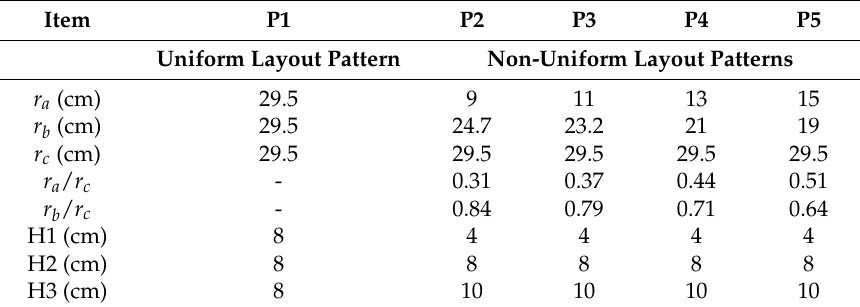
Figure 2. Block plan for non-uniform layout fillings. Table 2. Details for five different layout patterns.